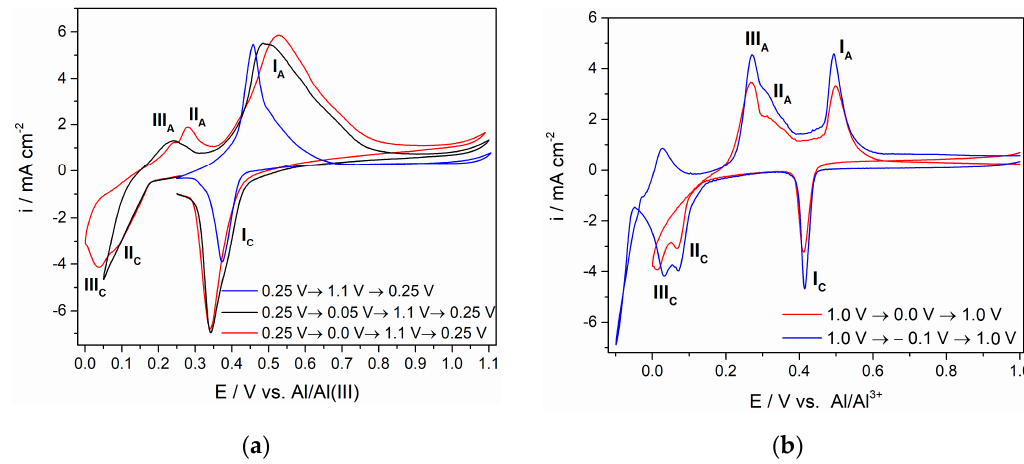
Figure 1. Voltammograms with a Ti working electrode in an equimolar AlCl 3 -NaCl melt ( T = 200 °C, v = 20 mV·s − 1 ): ( a ) potential changes during the first cycle from a starting point ( E I = 0.250 V) to an anodic potential limit ( E A = 1.100 V) and then back to 0.250 V and potential changes during the second and third cycles starting from E I = 0.250 V to different cathodic potential limits E C, then to E A and finally to a value E F = 0.250 V; ( b ) potential changes during cycles from a starting point ( E I = 1.000 V) to different cathodic potential limits and back to a final value ( E F = 1.000 V).